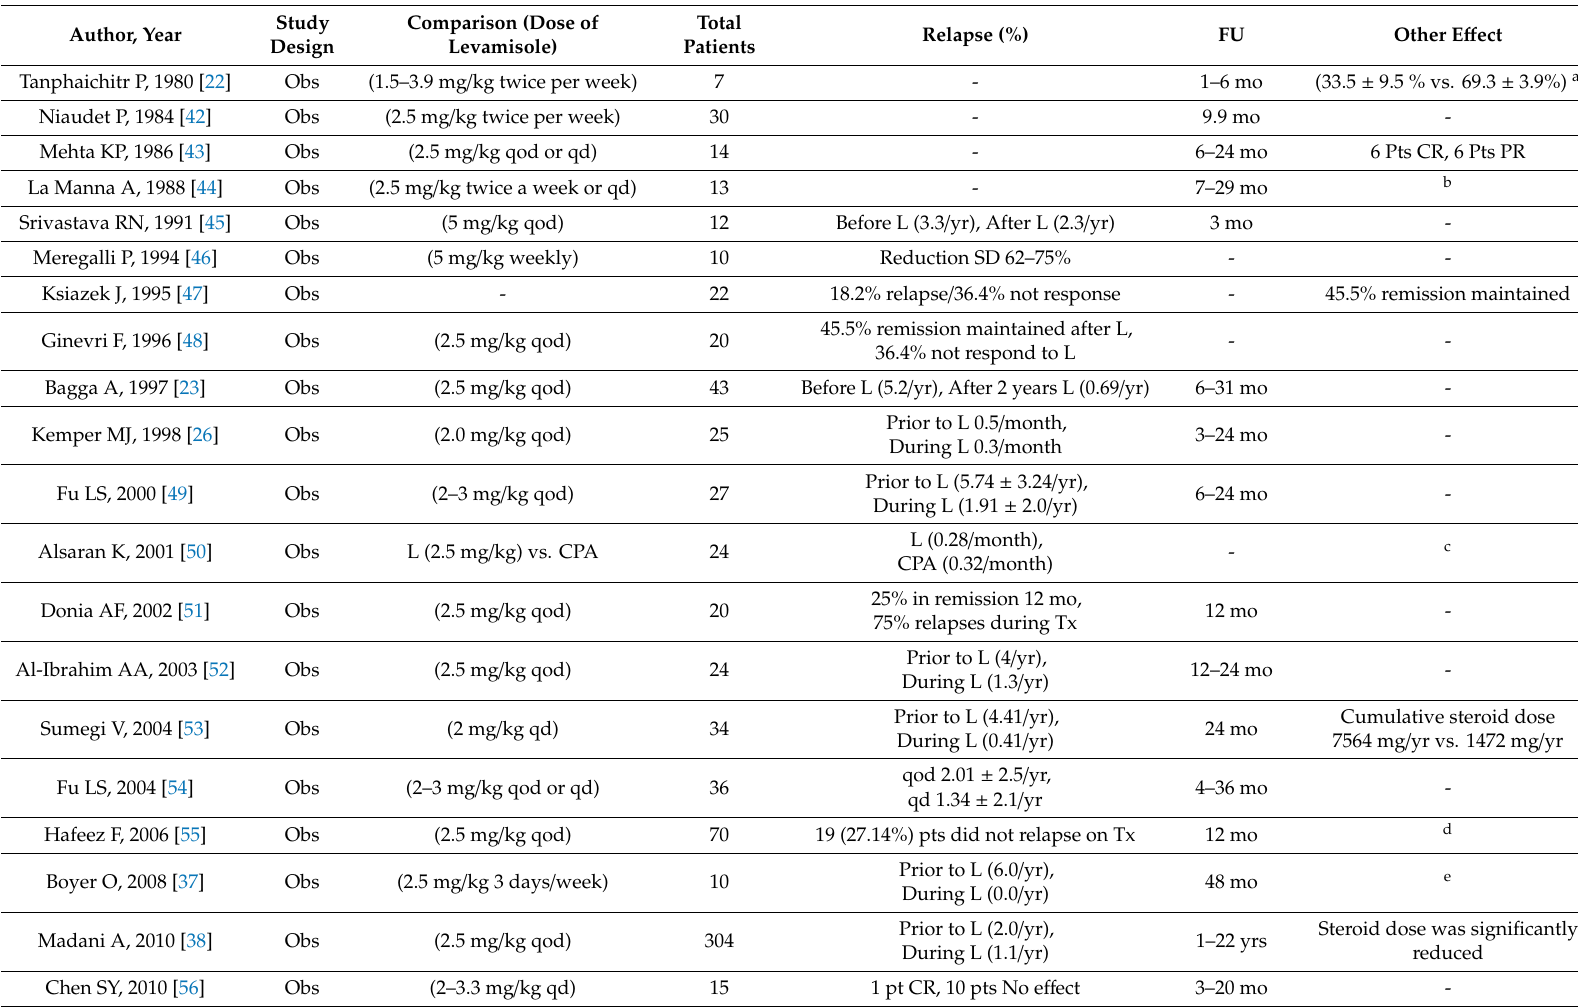
Table 1. Observational studies of steroid-dependent or frequent relapsing nephrotic syndrome treated with